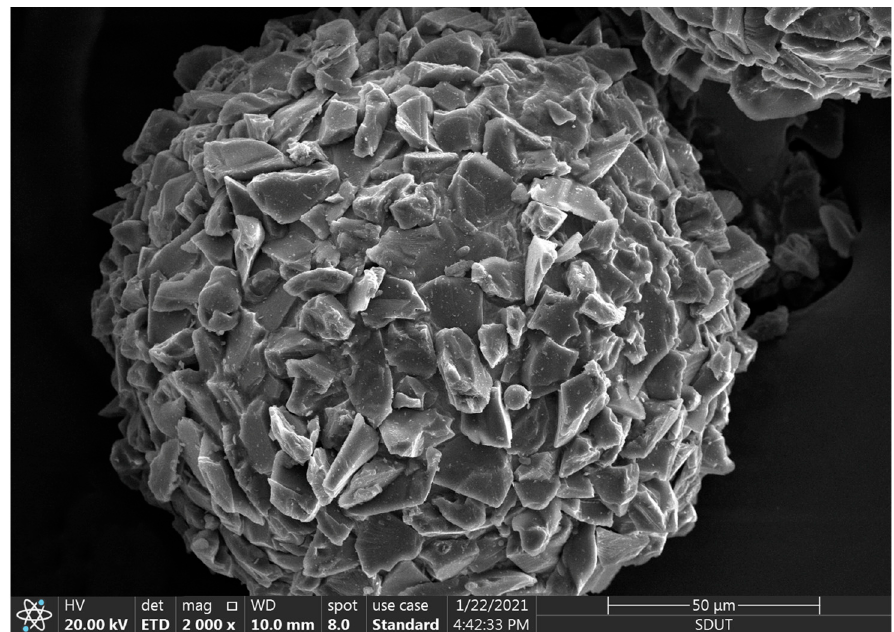
Figure 3. SEM image of spherical Al 2 O 3 magnetic abrasive.